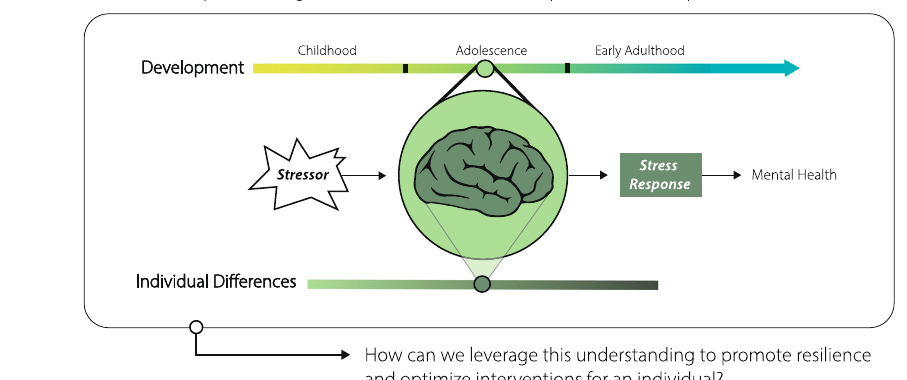
Fig. 1 | Framework for an approach to research that considers developmental and individual differences in stress responding to inform optimization of mental health interventions. Cross-species evidence has demonstrated hetero- geneity in mental health following stress exposure. Understanding how an indivi- dualrespondstoastressorcaninformhowbesttopromoteresilienceorintervene to reduce stress-related psychopathology. Here we conceptualize the stress responseasmultifaceted,encompassingchangesinneurobiologicalandendocrine function, subjective experiences, and thoughts, feelings, and behaviors. Differ- encesacrossdevelopmentandacrossindividualscanexplainvariationinresponses to stress and mental health. Given dynamic changes in neurobiological systems